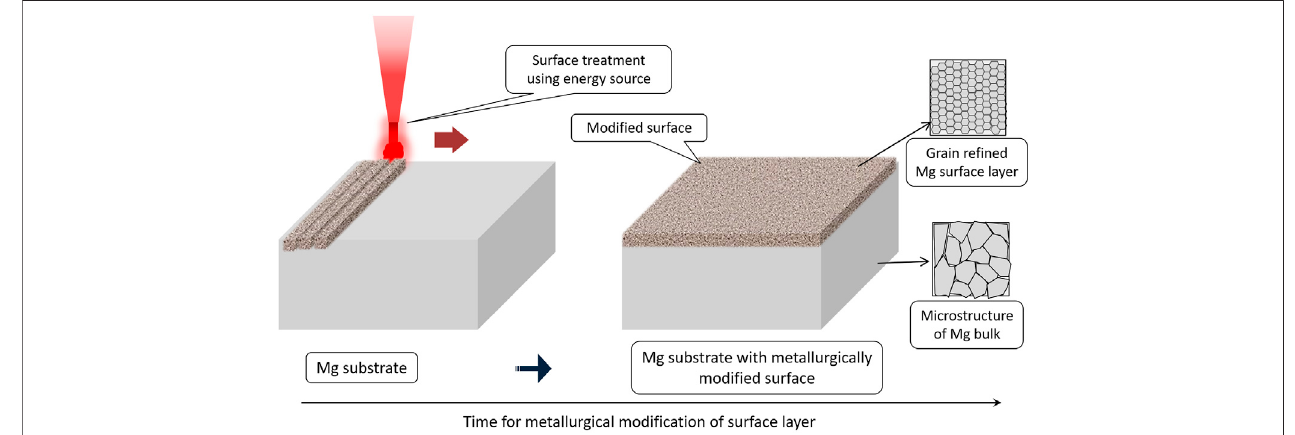
FIGURE 11 | Surface metallurgical modi fi